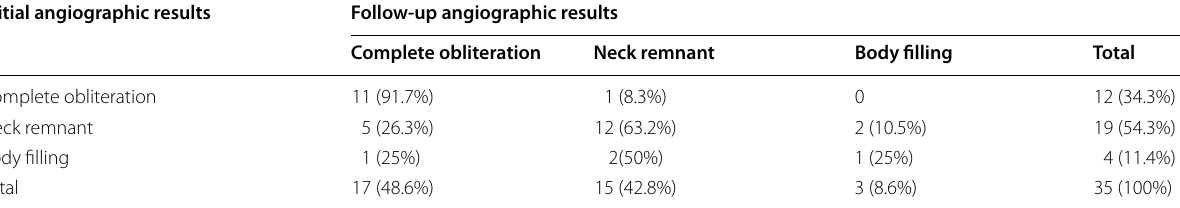
Table 3 Stability of the aneurysm after coiling Initial angiographic